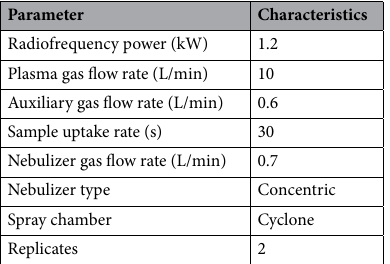
Table 3. Operational conditions of inductively coupled plasma optical emission spectrometry (ICP-OES) with axial